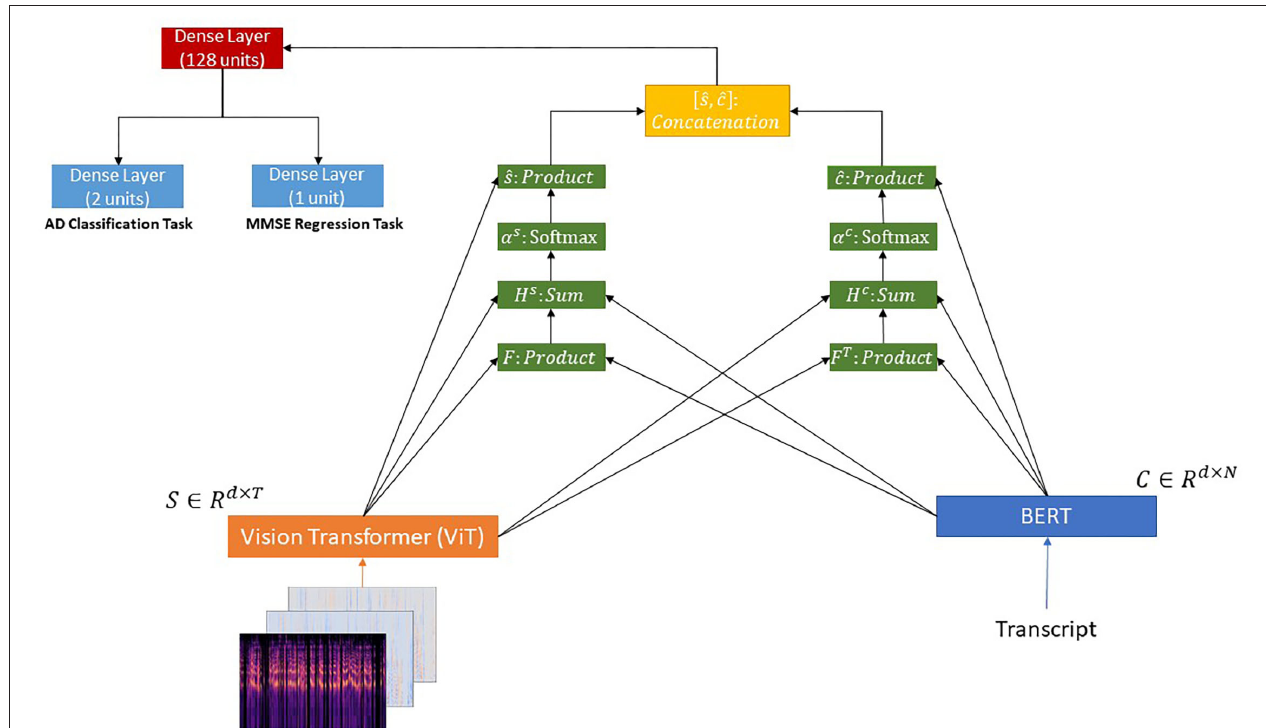
FIGURE 1 | BERT + ViT +